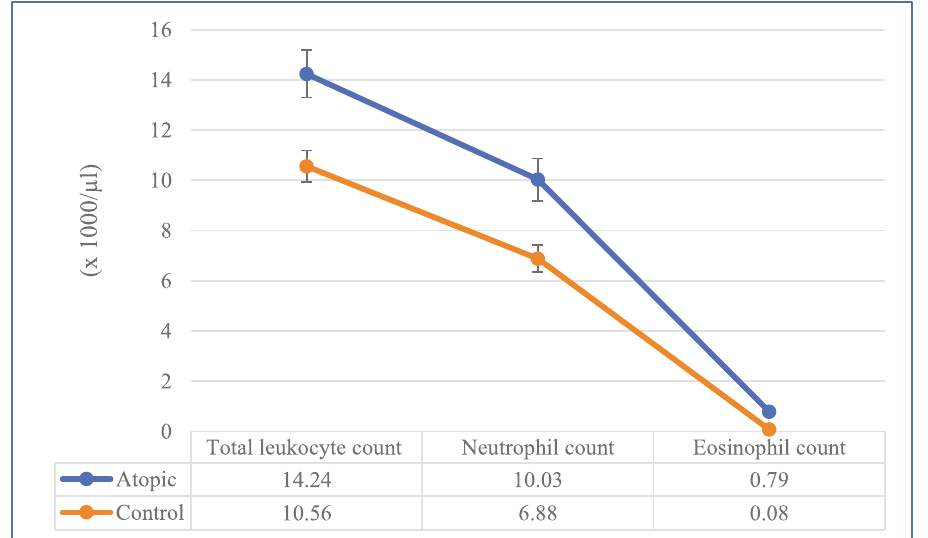
Fig.4. Total leukocyte, neutrophil and eosinophil count in atopic and healthy controls table 3. Platelet indices in atopic animals and healthy controls Variables